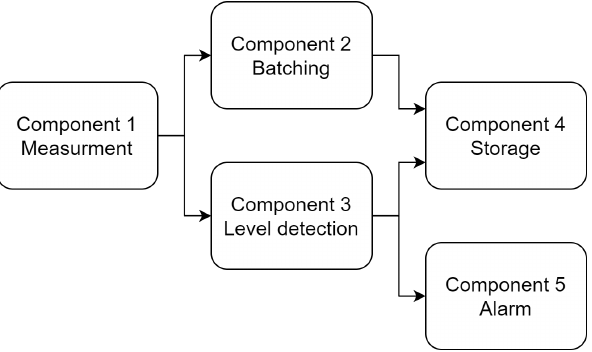
Figure 8. Smoke monitoring application.